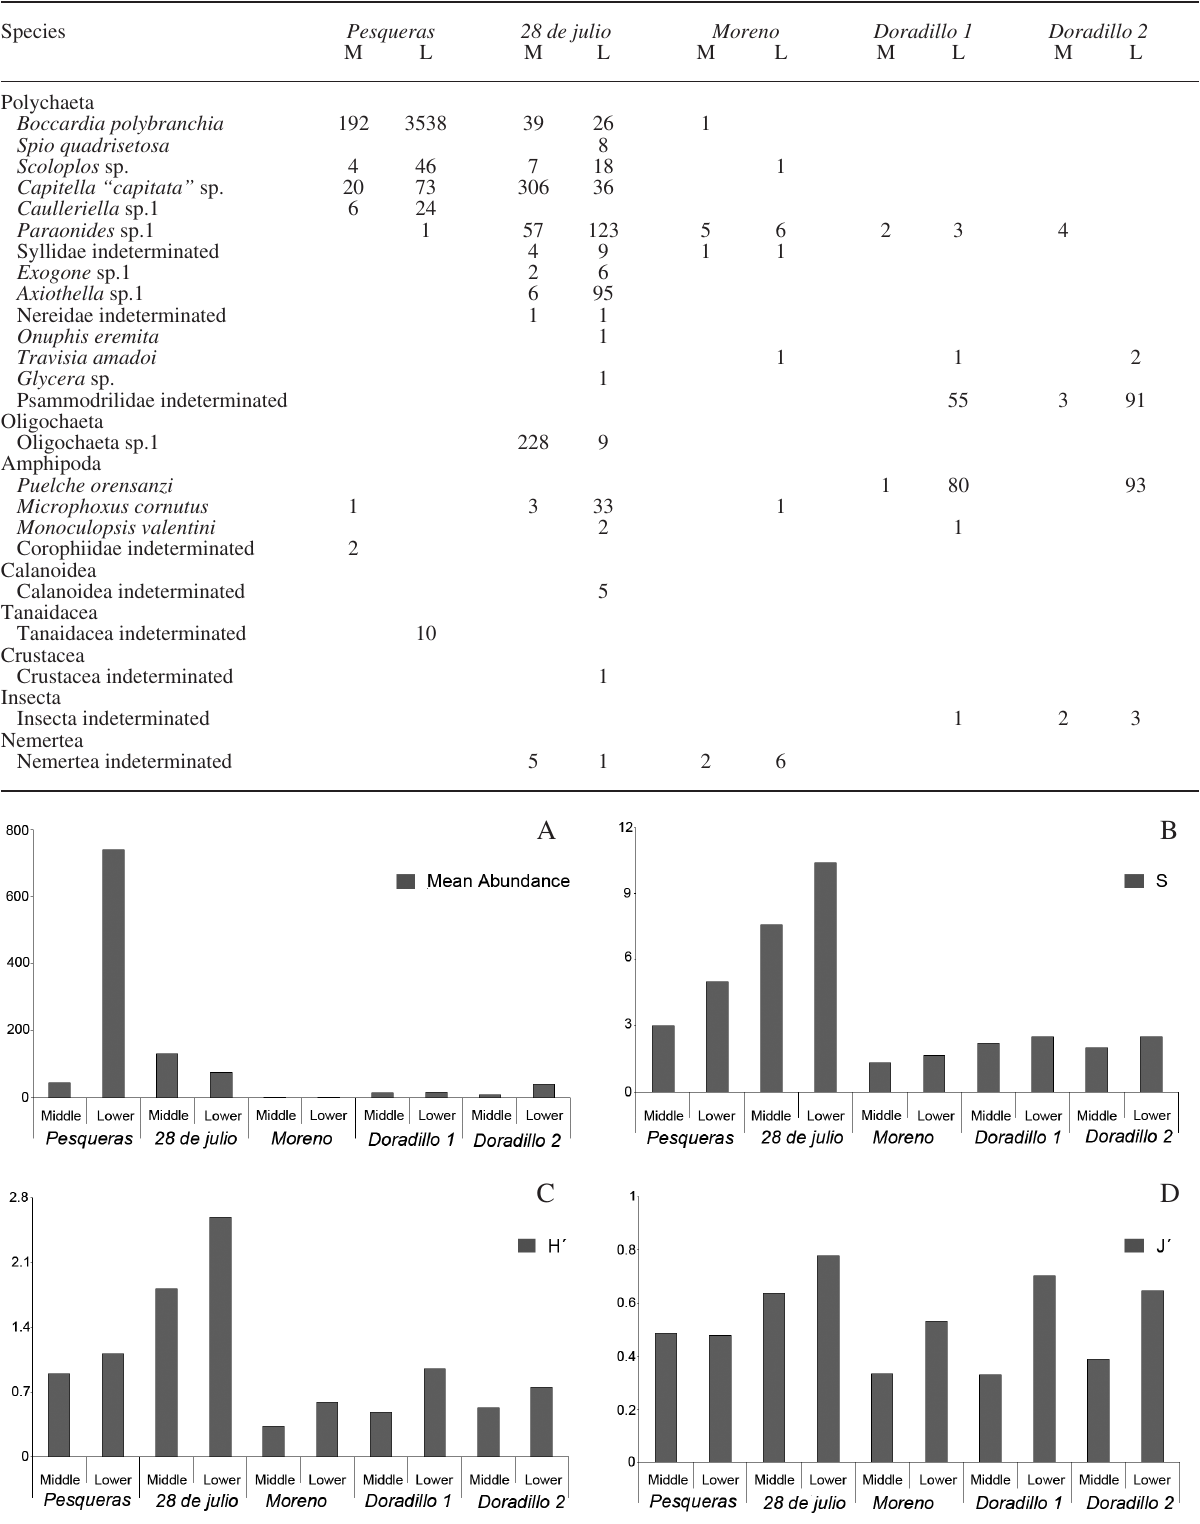
Table 1. – Total abundance (number of individuals) of species (5 replicates) by levels and collection sites (M: middle level; L: lower level). Species